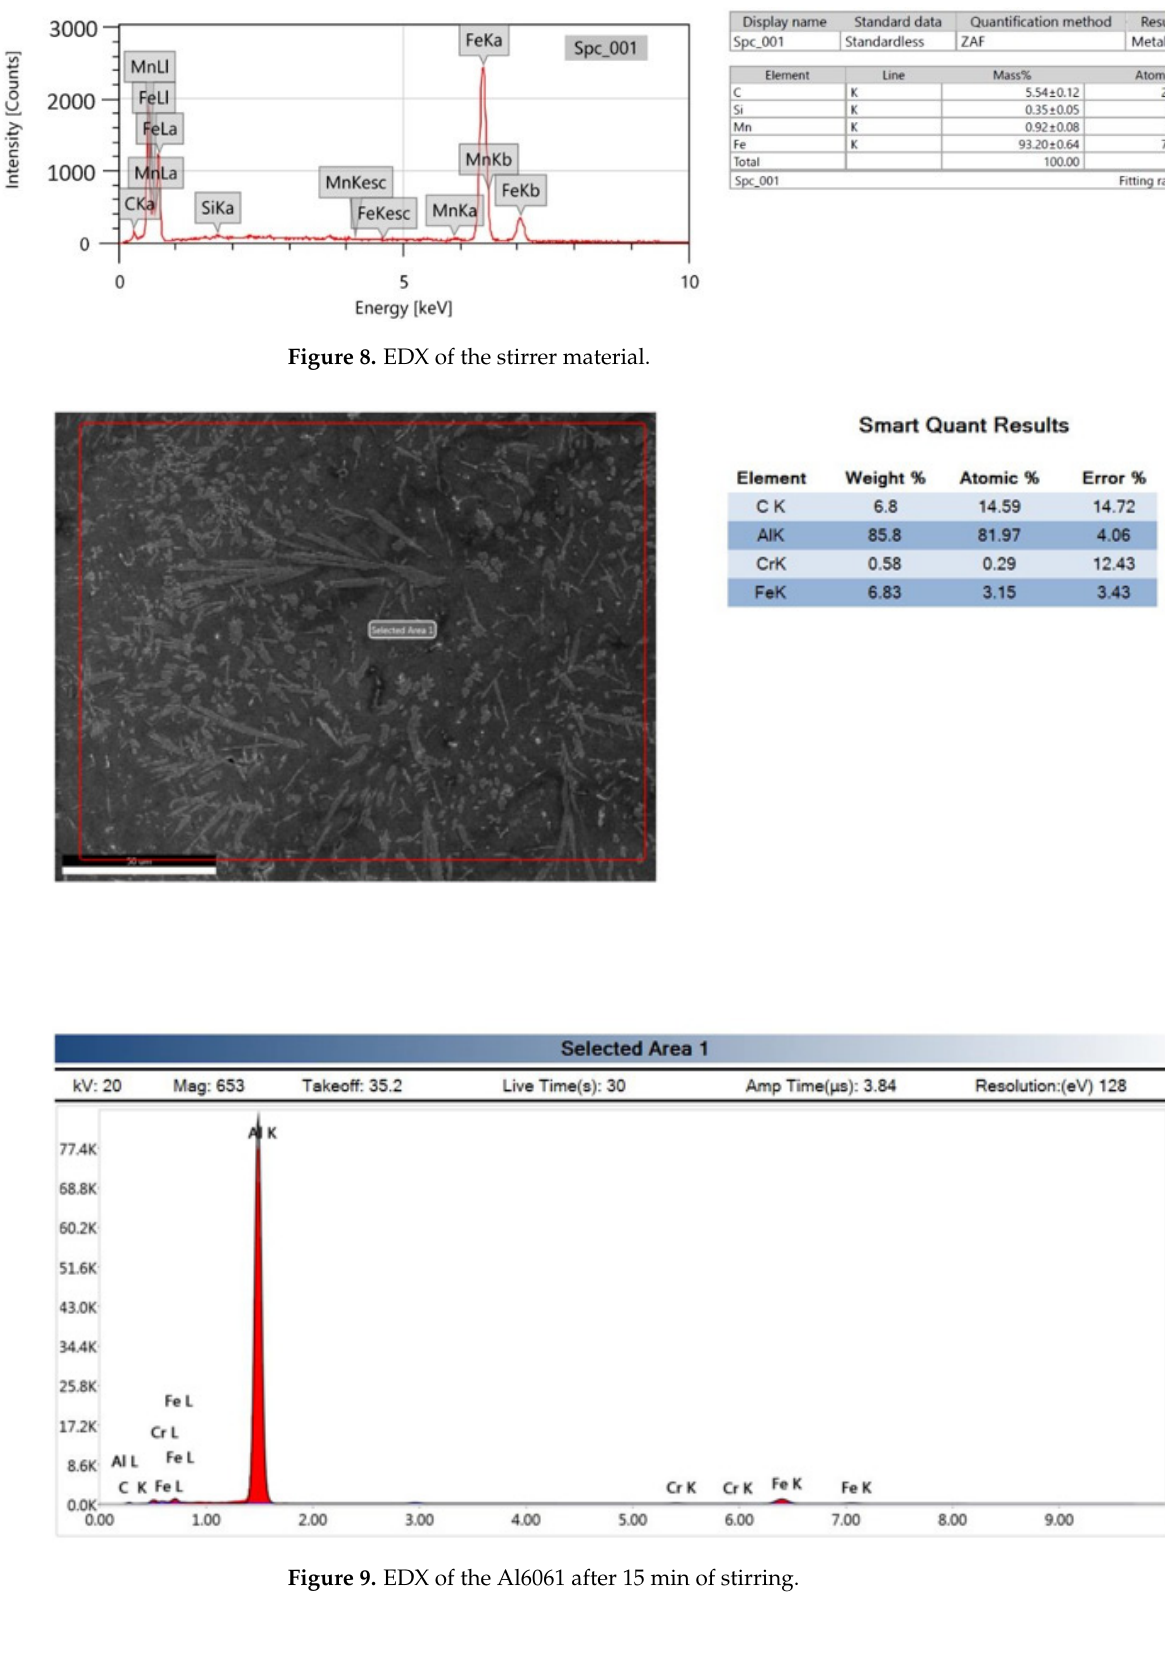
volume fractions for different stir casting duration times.